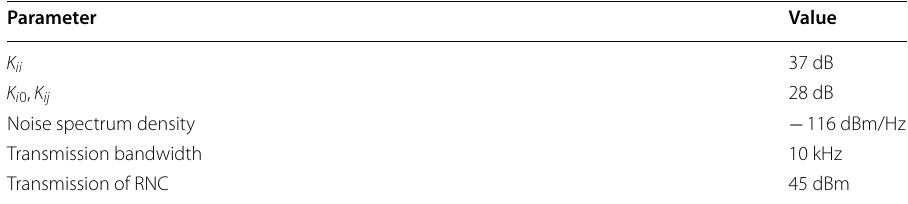
Table 1 Simulation parameters setting Parameter